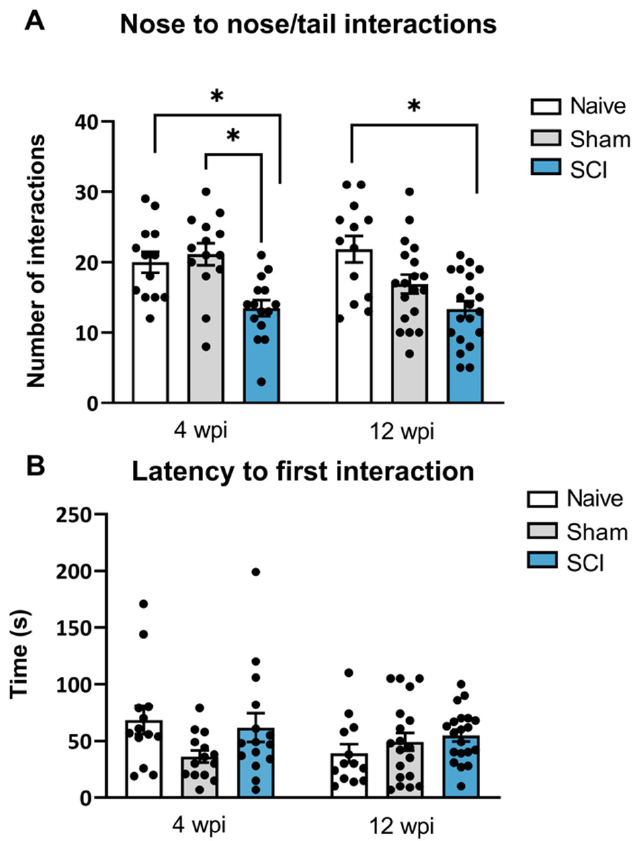
Figure 4. Social interaction test after mild spinal cord injury (SCI). Social behavior deficits were detected in SCI mice as they showed a decreased number of nose-to-nose/tail interactions ( A ) with a conspecific mouse both at 4 wpi and 12 wpi. No differences were obtained for the latency of first interaction with conspecific mice ( B ) Results are the mean ± SEM. * p < 0.05 (one-way ANOVA followed by Tukey’s post-hoc test). SCI, spinal cord injury; wpi, weeks post